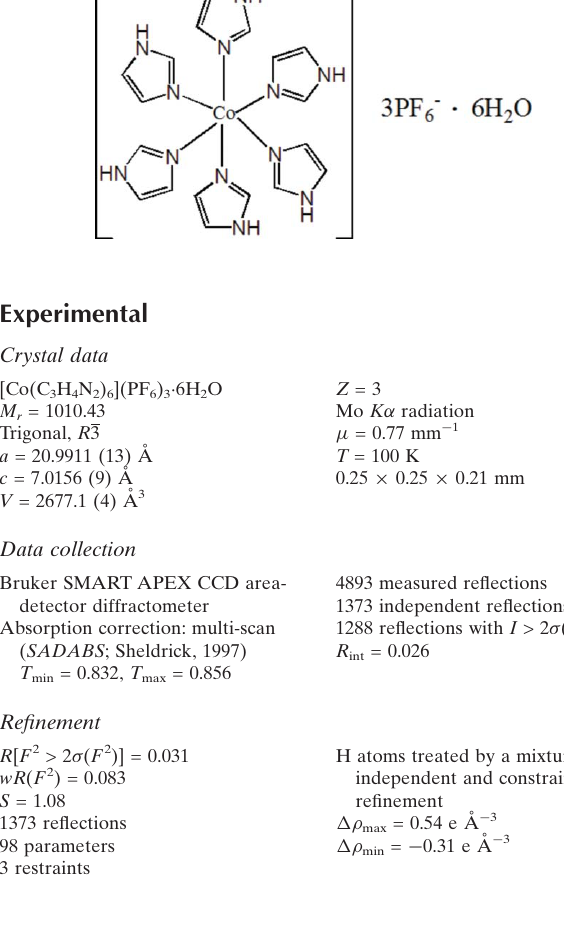
Hydrogen-bond geometry (A˚ , (cid:5) ).